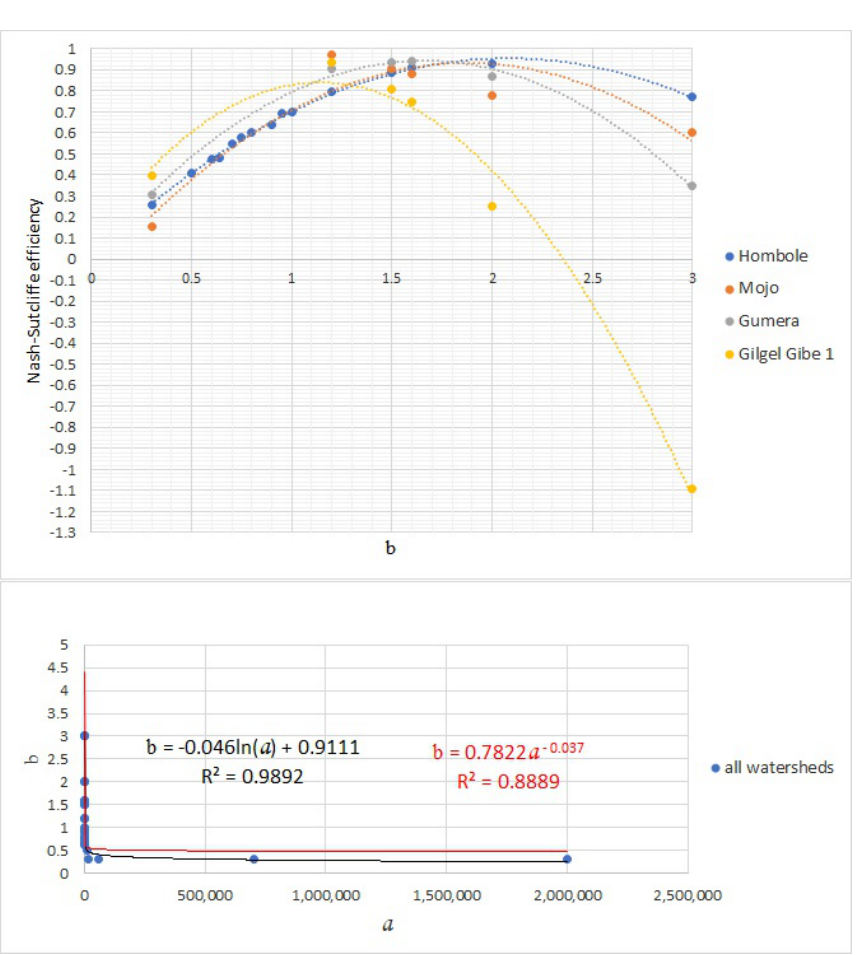
Figure 8. The relationship between exponent b and the Nash–Sutcliffe efficiency as well as coefficient a versus the exponent b when the topographic factor is calculated by using the equation that was proposed in